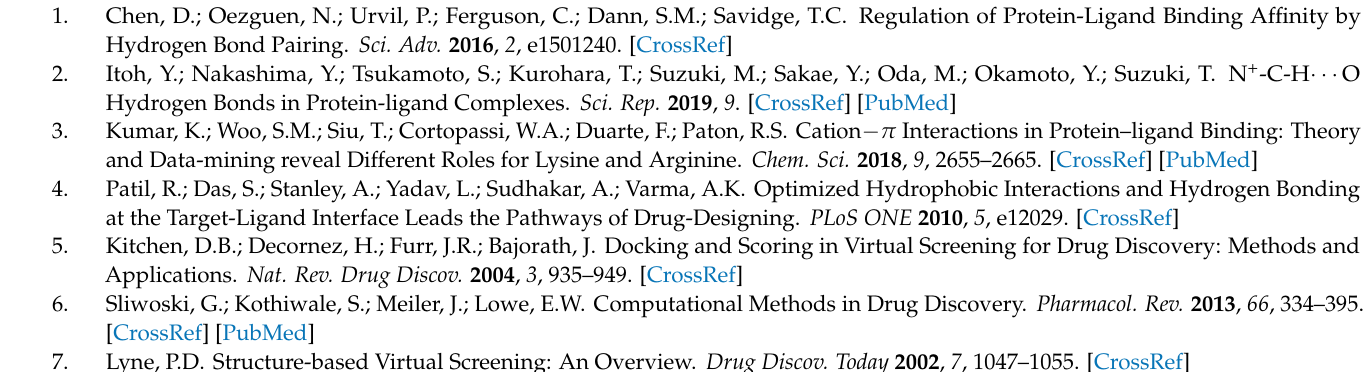
model overfits when convolution neural network is applied to smaller datasets, such as human or C. elegans ; Figure S4: Receiver operating characteristics for the predictions on DUD-E dataset; Figure S5: Receiver operating characteristics for the predictions on BindingDB dataset; Figure S6: t-SNE plot for all the proteins (30) in the test set of DUD-E dataset. Each cluster is distinguishable with others and denotes a protein. Note that the SSnet model had no information about these proteins as they were in the test set and is yet able to distinguish them; Figure S7: SSnet model training loss over (a) DUD-E dataset and (b) BindingDB dataset; Figure S8: Dynamic model optimization for SSnet:DUD-E; Figure S9: Various model performance on maximum unbiased validation (MUV) targets for AUCROC; Figure S10: Grad-CAM visualization of the heatmap for nine different proteins with their PDB ID. The heatmap is a rainbow mapping with violet as the lowest and red as the highest value. The ligand and other small molecules are shown in grey; Figure S11: SSnet:BDB performance when various cutoff for IC50 is applied and tested 102 targets of DUD-E dataset. The mean score for AUCROC are 0.77, 0.76, and 0.73 for 100, 25, and 10 nM cutoff, respectively. The mean score for EF 1% are 15, 16, and 10 for 100, 25, and 10 nM cutoff, respectively; Figure S12: Relation of SSnet scores when different conformations of the same protein are used. The black line shows y = x line; Table S1: Model comparison on the DUD-E dataset for various ligand descriptors; Table S2: MUV data details; Table S3: EF 0.5% comparison on MUV dataset; Table S4: EF 1% comparison on MUV dataset; Table S5: EF 5% comparison on MUV dataset; Table S6: AUCROC comparison on DUD-E test set; Table S7: EF 1% comparison on DUD-E test set; Table S8: AUCROC comparison on the BDB test set; Table S9: Ligand similarity for BDB train dataset to DUD-E dataset; Table S10: Protein fold similarity from BDB train dataset to DUD-E